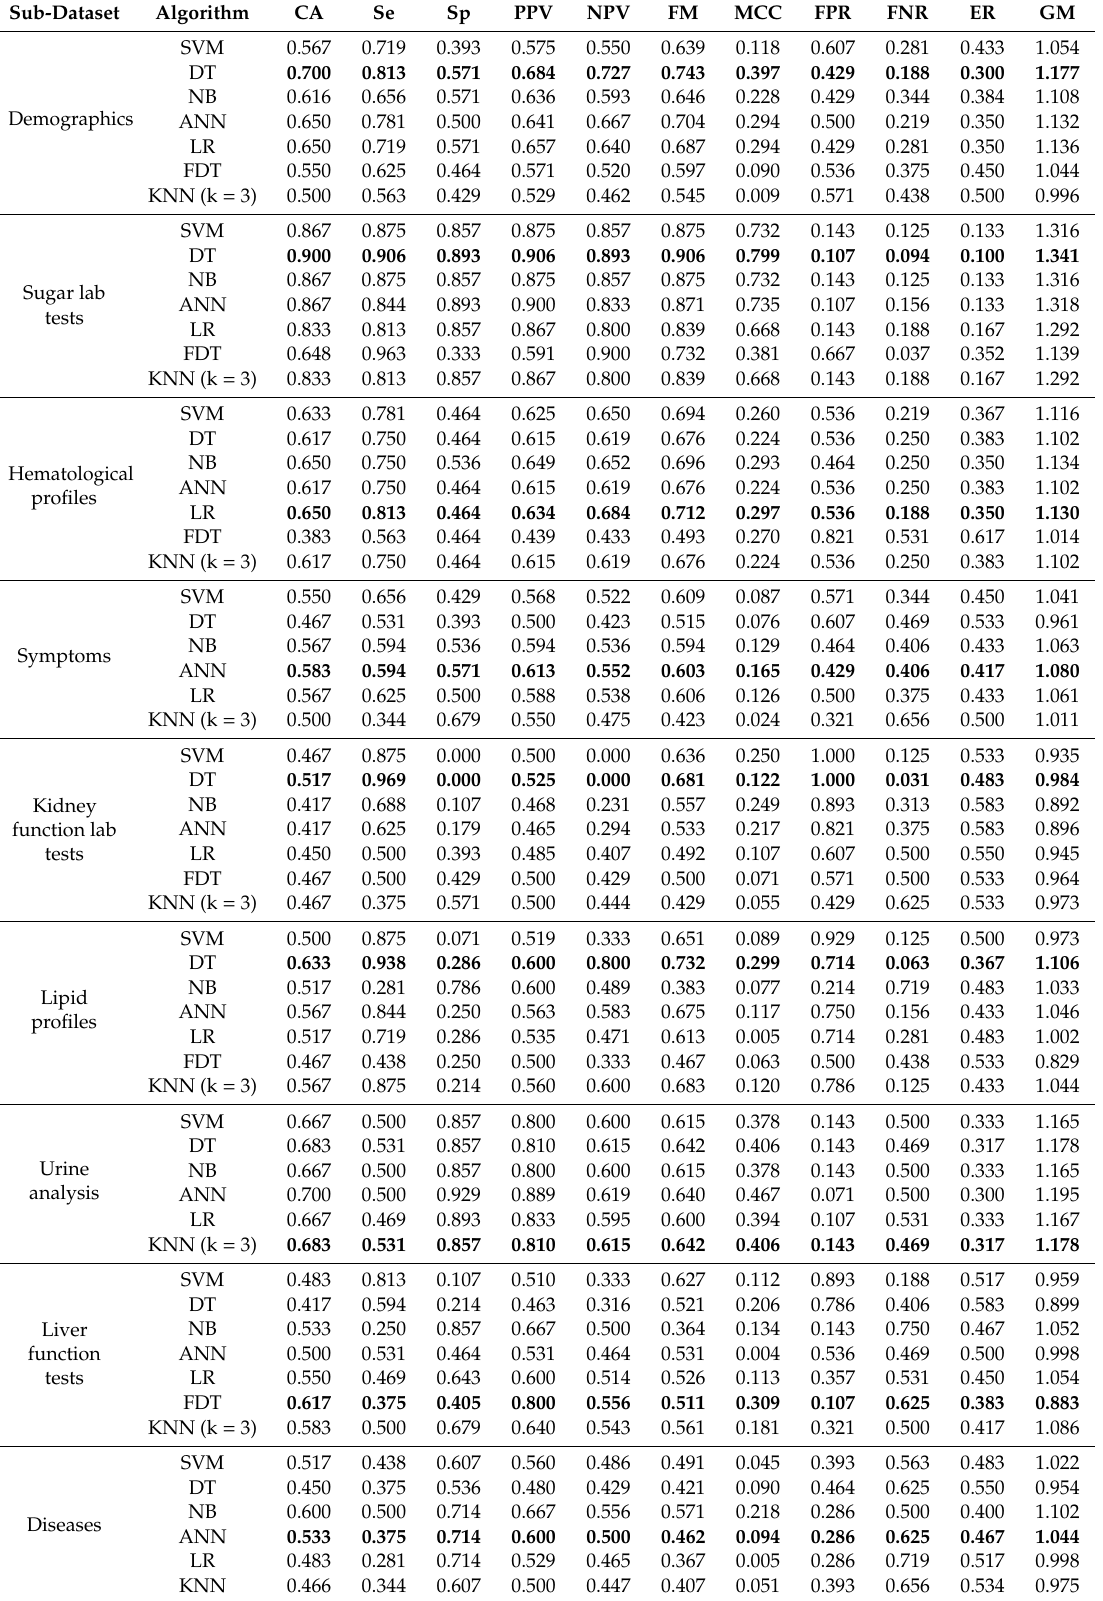
Table 2. The comparison of base classifiers for all datasets using CFS and 10-fold cross-validation.